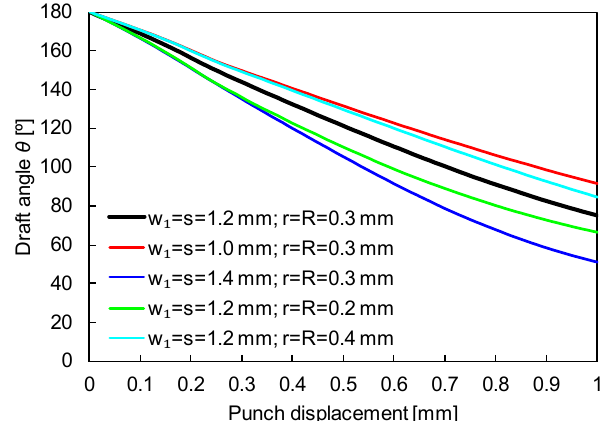
Figure 13. Draft angle evolution obtained for three values of channel/rib width and three values of punch/die fillet radius (plane strain conditions).